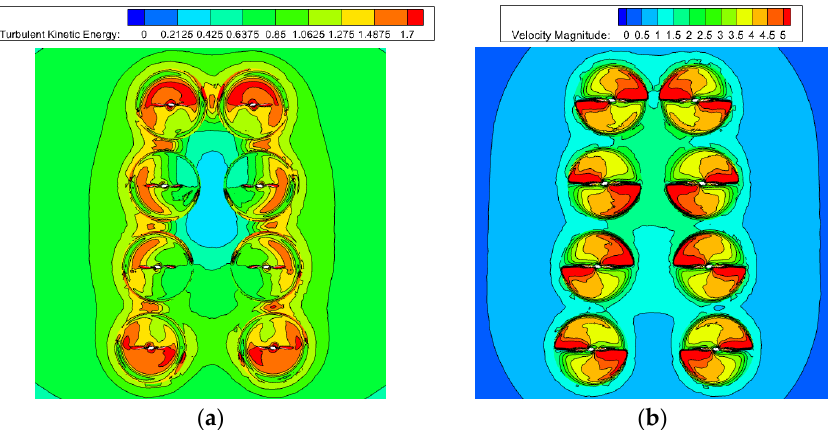
Figure 13. Turbulent kinetic energy and velocity distribution at G3. ( a ) Turbulent kinetic energy; ( b ) Velocity.